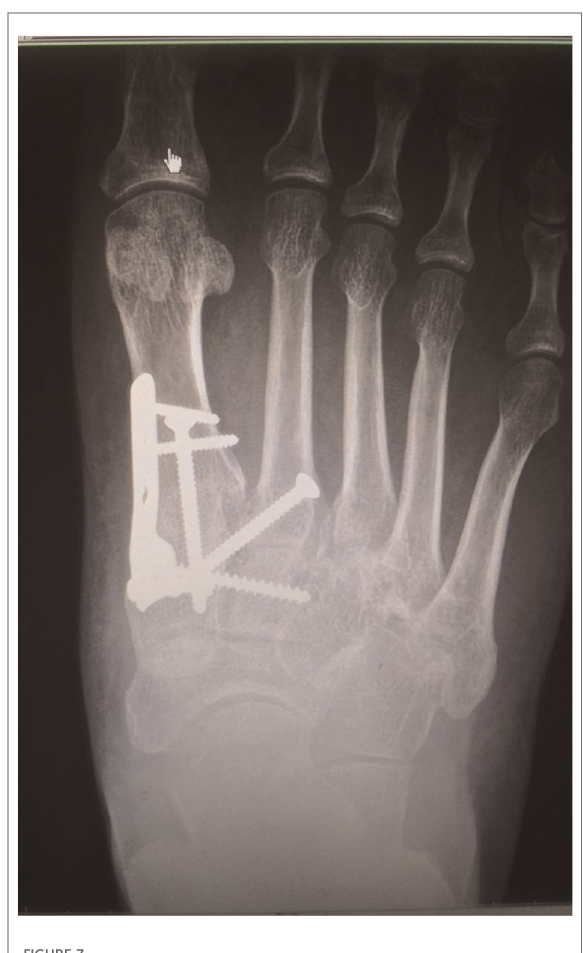
FIGURE 7 Radiographs of the foot of a patient in group A at 1 year after surgery.